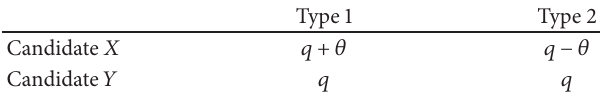
Figure 1: Logit response function relative to cost cutpoint 𝑐 ∗ . Table 2: Payoffs